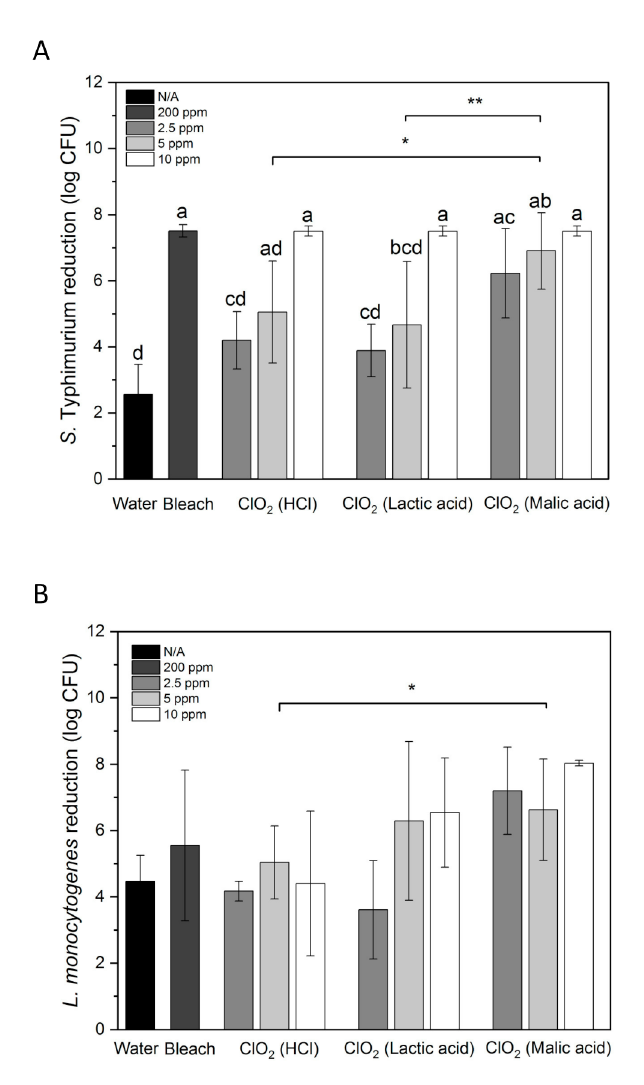
Figure 2. S. Typhimurium ( A ) and L. monocytogenes ( B ) reduction by water, 200 ppm bleach, and aqueous ClO 2 generated by mixing NaClO 2 with HCl, lactic acid or malic acid on whole papayas. Error bars are standard deviations ( n = 3). Bars labeled with different letters indicate significant differences between the means of treatments ( p < 0.05). Lines labeled with “*” indicate significant differences between ClO 2 groups made with different acids (“*”, p < 0.05; “**”, p <